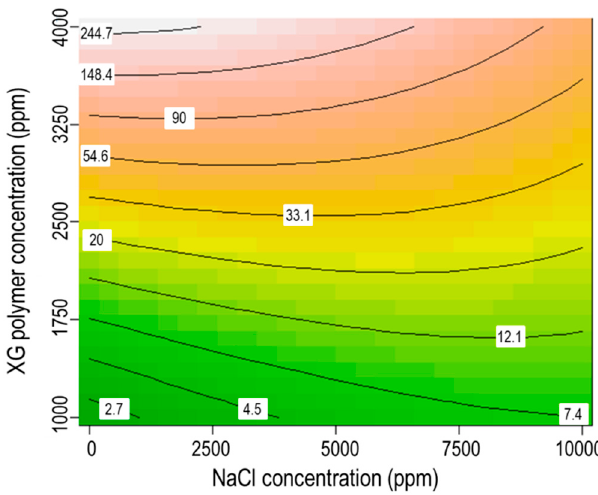
Figure 8. Interaction between xanthan gum (XG) polymer concentration and salinity at sodium dodecyl sulfate (SDS) surfactant concentration = 2500 (ppm) and stirring rate = 7000 (rpm).